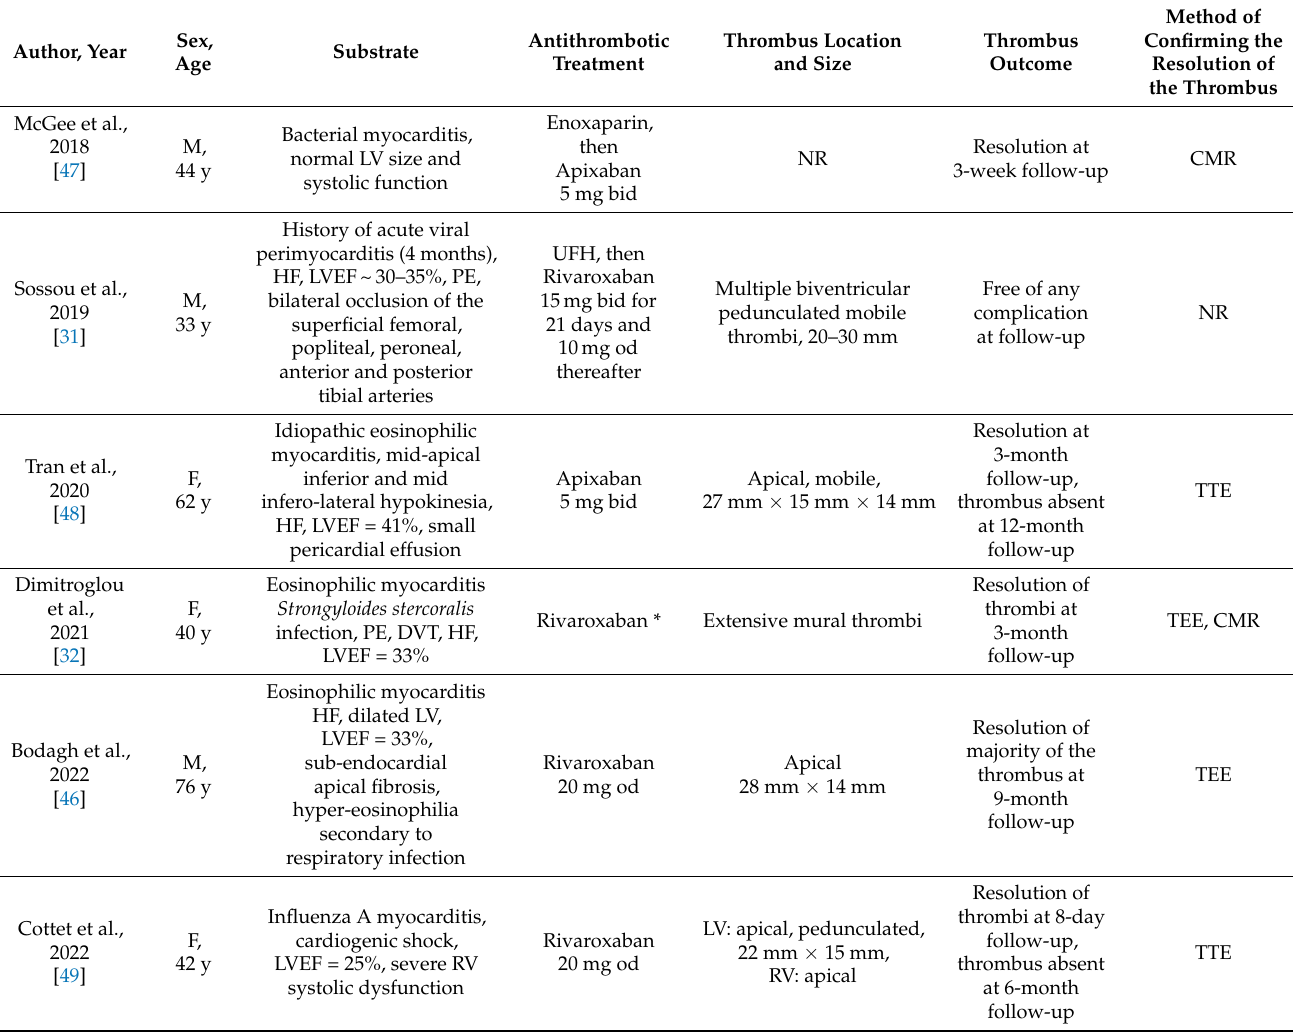
Table 1. LV thrombus in patients with